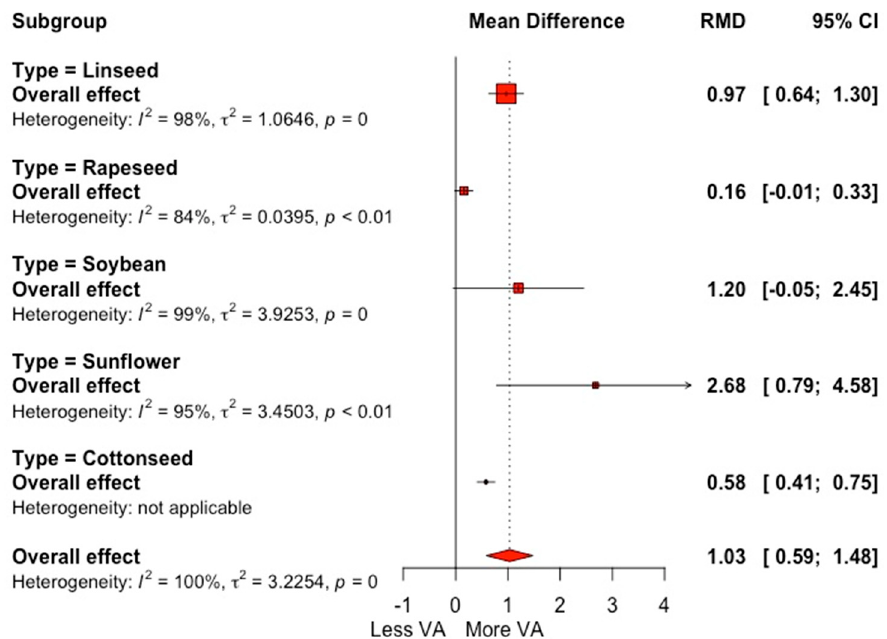
Figure 3. Forest plot of vaccenic fatty acid (VA; g 100 g − 1 FA) for trials with the inclusion of oilseeds in dairy cow diets, grouped by type of oilseed. Point size reflects the relative weighting of the study to the overall effect size estimated, where a larger point size represents a greater weight and the combined effect size estimated, including the confidence intervals. The diamond represents the overall effect. RMD, raw mean difference.